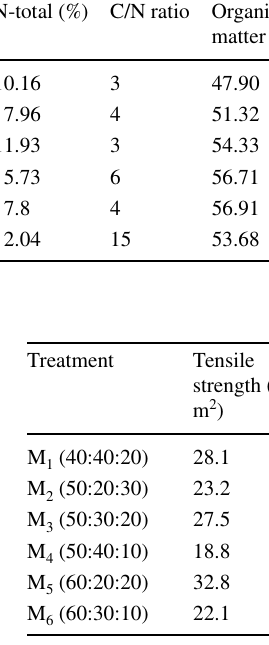
Table 1 The results of chemical analyses on organic materials for organic mulch sheet Treatment